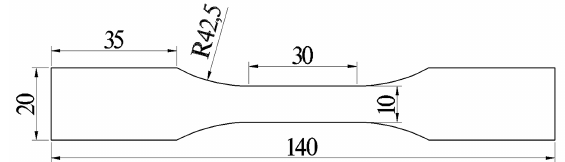
Figure 3. Dimensions of the fatigue test specimen (unit: mm).